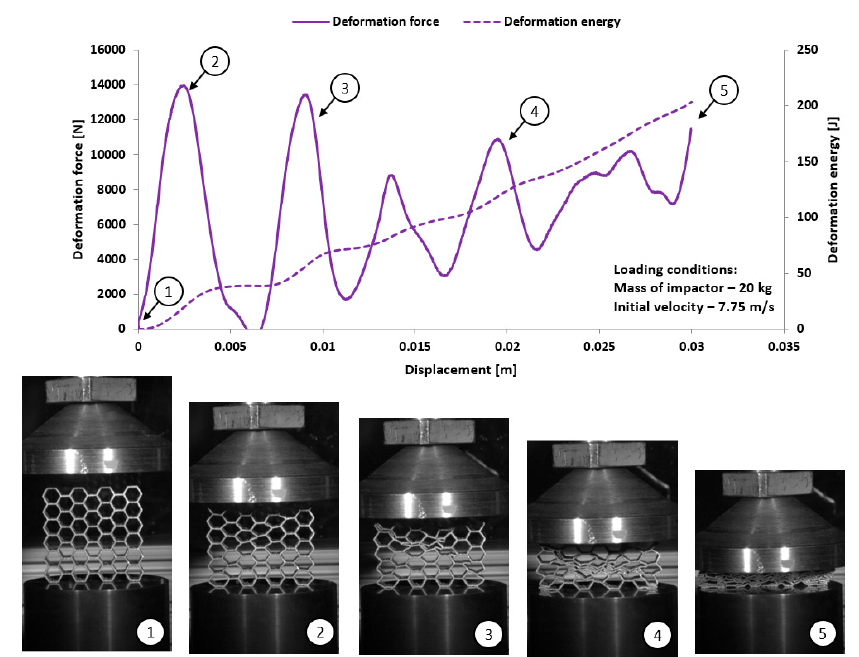
Figure 20. The results of dynamic tests obtained for honeycomb specimen No .4 (1-5 stages of deformation during dynamic compression